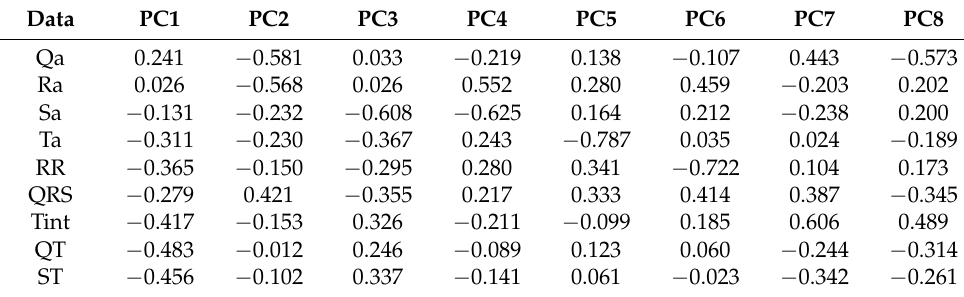
Table 4. Summary of principal components using factored data.